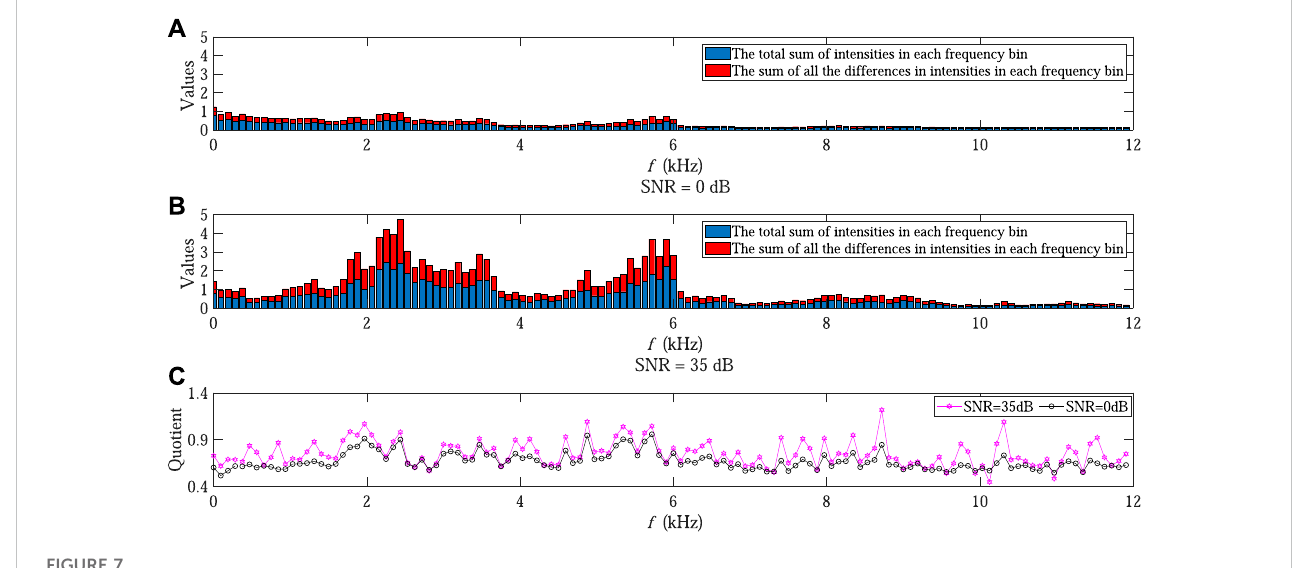
FIGURE 7 In fl uence mechanism analysison ACI in Experiment 2. (A,B) presentthe values of thenumerator and denominator at each frequency binwithin a certain temporal step under 0 dB and 35 dB SNR conditions, respectively. The red bars represent the total differences in intensities at each frequency bin while the blue bars represent the total sum of intensities at each frequency bin. The corresponding quotient at each frequency bin is shown in (C) , where the black and purple points denote the values in 0 dB and 35 dB SNR conditions,